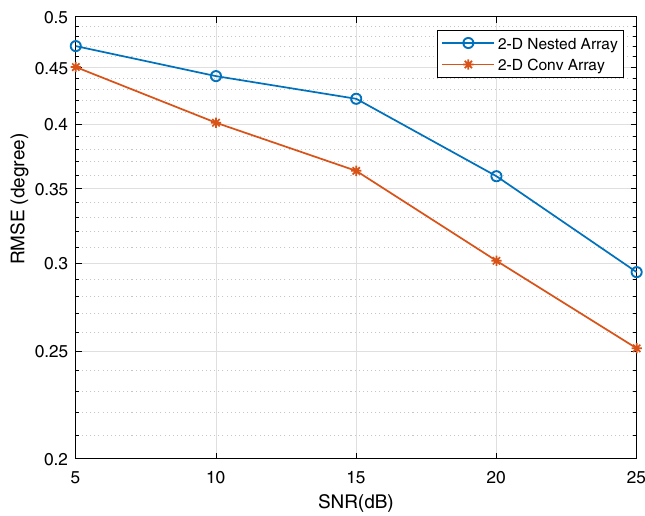
Fig. 10 RMSE versus SNR for 2D DOA estimation, snapshots